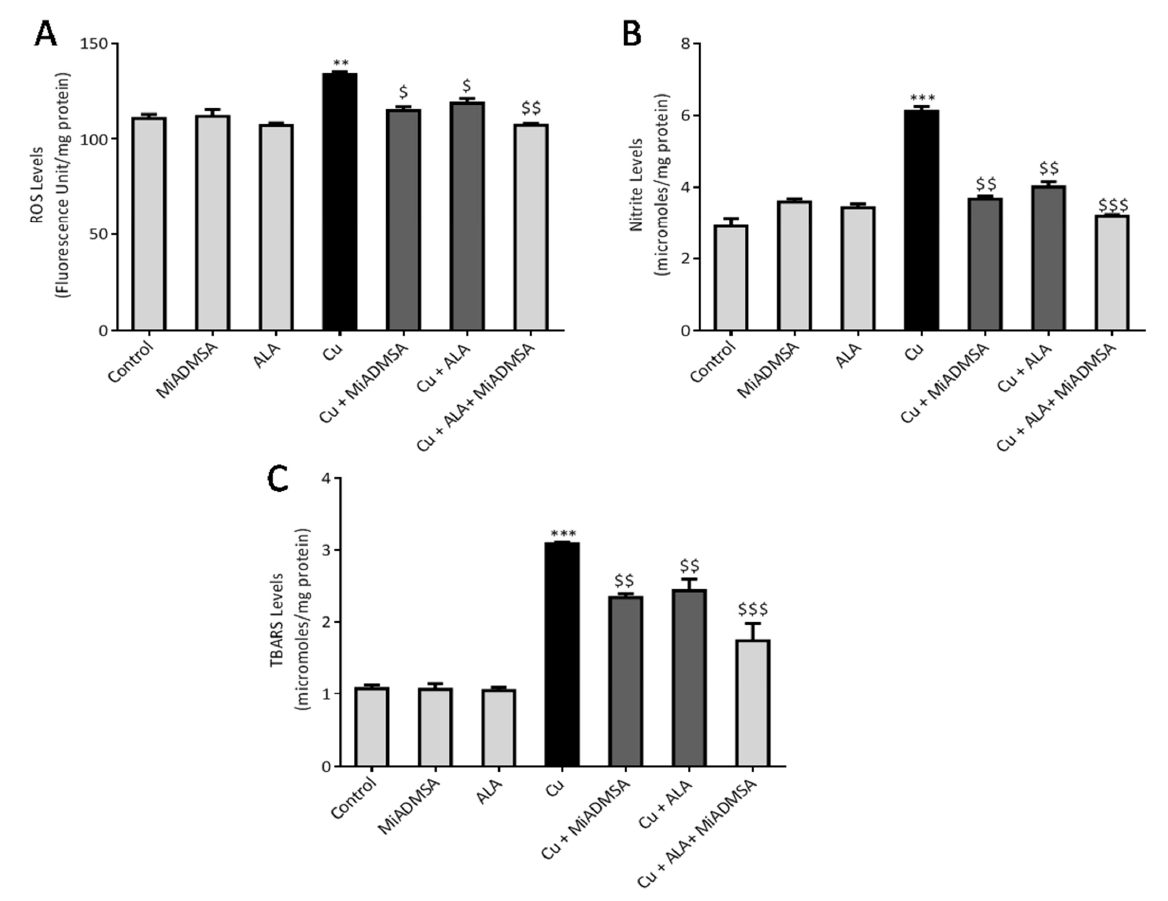
Figure 11. The MiADMSA and ALA combination treatment mitigates the augmented brain ROS, nitrite, and TBARS levels. ( A ) Brain ROS level; ( B ) Brain nitrite level; ( C ) Brain TBARS level. All the values are expressed as mean ± S.E.M. ( n = 6) ** p <0.01, *** p < 0.001 vs. control and $ p < 0.05, $$ p < 0.01, $$$ p < 0.001 vs. Cu.